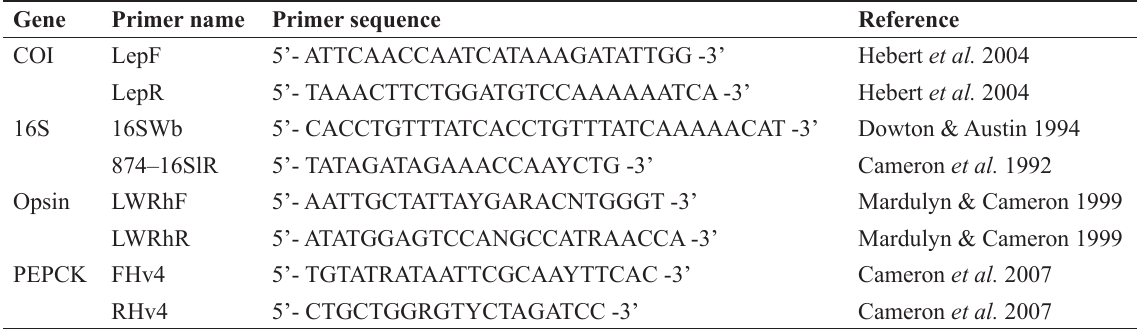
Table 2. Primer sequences for the sequenced regions of the four